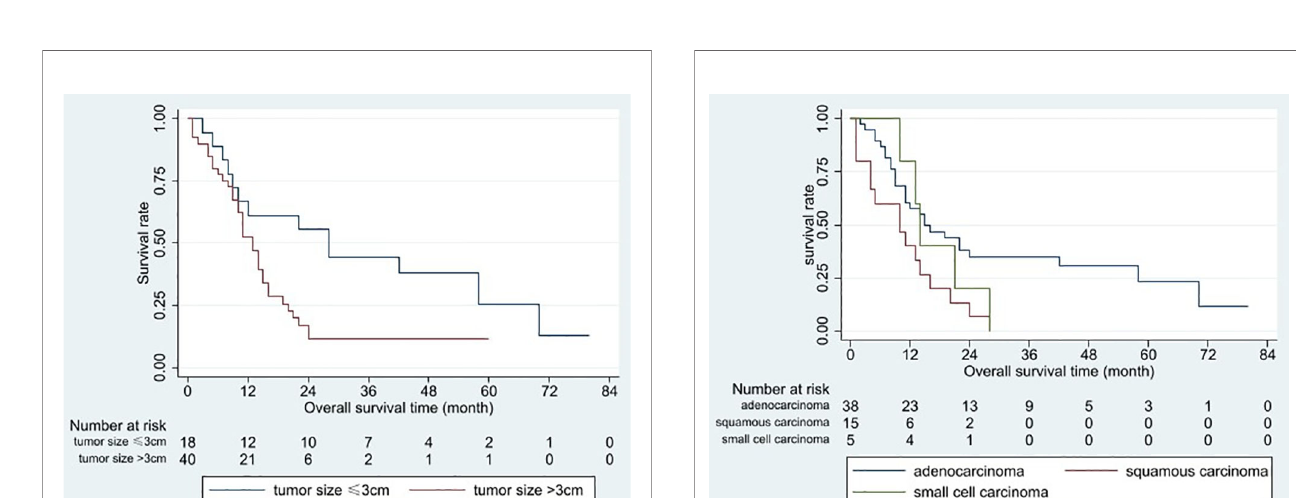
FIGURE 2 | A 68-year-old man was diagnosed with left lung adenocarcinoma and received radiotherapy and chemotherapy for the lung lesion. After 27 months, metachronous liver metastasis was detected by magnetic resonance imaging. The patient underwent percutaneous radiofrequency ablation for liver metastasis. Until the last follow-up, the patient was alive, surviving 30 months without recurrence. (A) The liver metastasis in segment VI, as detected by magnetic resonance imaging. (B) Contrast-enhanced ultrasound showing a 2.1-cm liver tumor in segment VI. (C) Contrast-enhanced computed tomography at 1 month after radiofrequency ablation demonstrating the successful ablation of the tumor. (D) Contrast-enhanced computed tomography at 30 months after radiofrequency ablation showing that the ablation zone shrunk without local recurrence or new liver metastases.